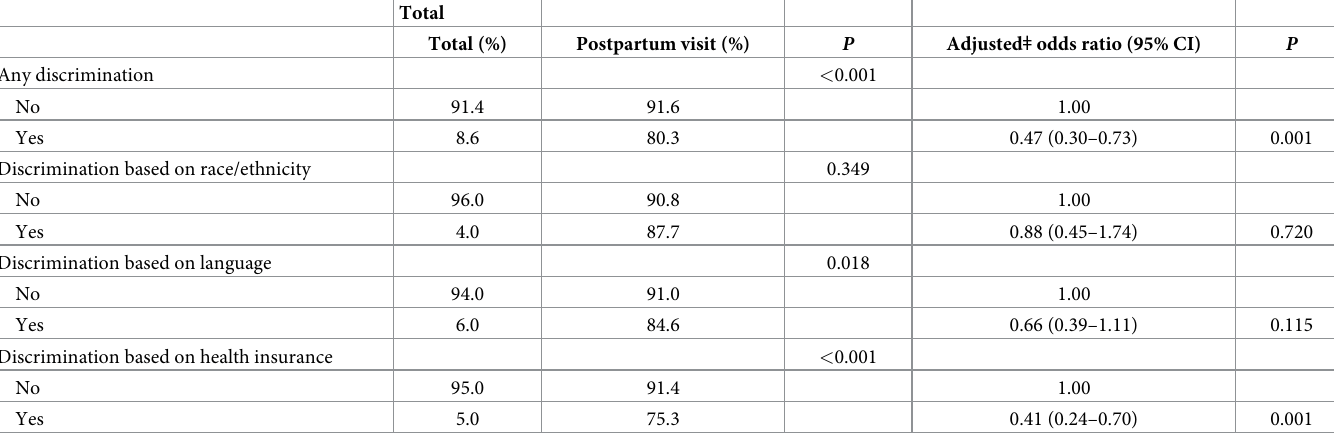
Table 2. Perceived discrimination during the childbirth hospitalization and postpartum visit attendance (N = 2,295).